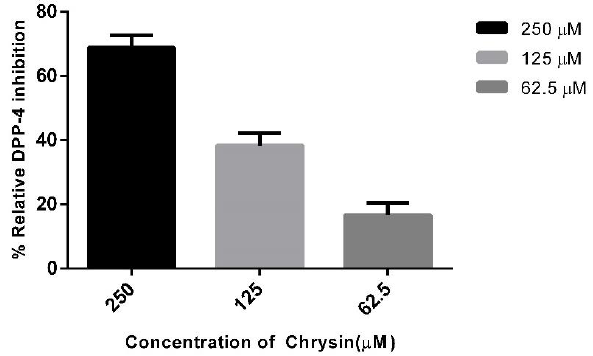
Figure 5. Different concentrations of chrysin and their relative percent of inhibition of DPP-4 enzyme activity. Data are represented as mean ± standard error.